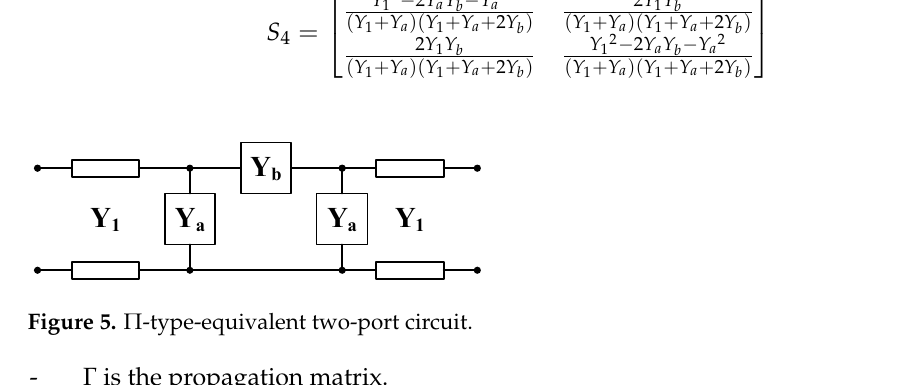
Y 2 Y a Figure 4. T-type equivalent two-port circuit. The equivalent two-ports of the special-shaped structure node are Π-type ones (Fig- ure 5), and scattering matrix (cid:1845) (cid:2872) is: